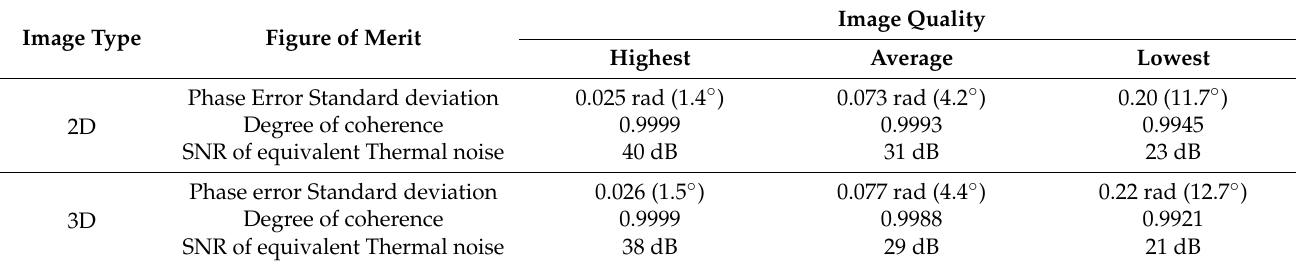
Table 6. Performance of the configurations with highest, average, and lowest image quality. Image Type Figure of